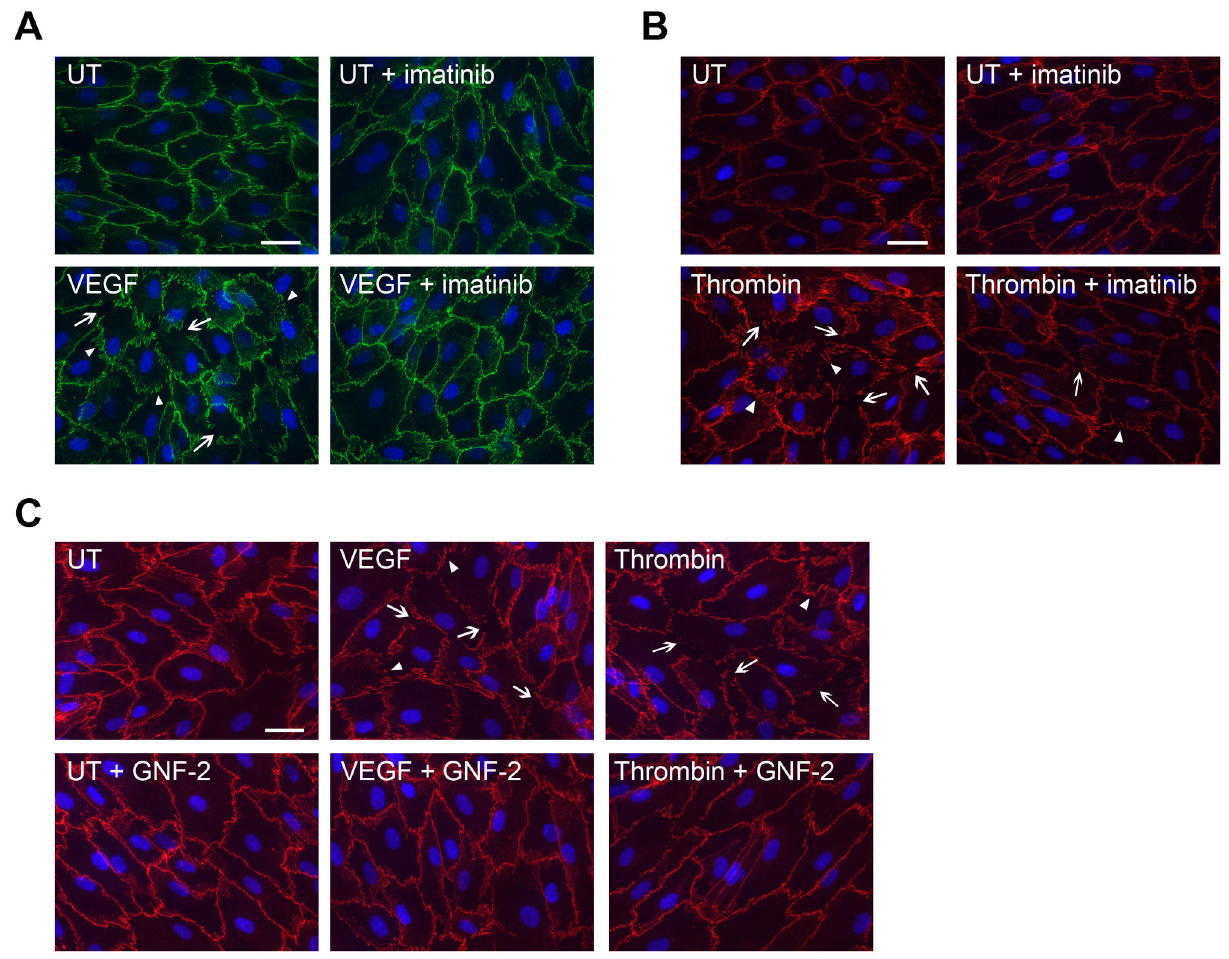
Figure 4. Abl kinase activity is required for VEGF- and thrombin-induced disruption of endothelial adherens junctions. ( A ) Staining of HMVEC monolayers for the adherens junction marker VE-cadherin (green) following treatment with VEGF (100ng/mL, 30 minutes), with or without imatinib pre-treatment (10μM). ( B ) VE-cadherin staining (red) of HMVEC monolayers treated with thrombin (1U/mL, 5 minutes), +/- imatinib. ( C ) VE-cadherin staining (red) of VEGF or thrombin-treated HMVECs, with or without GNF-2 pre-treatment (15μM). VEGF and thrombin treatment induced formation of inter-endothelial cell gaps (arrows) and destabilization of endothelial cell-cell junctions (“zig-zag” VE-cadherin staining pattern, arrowheads), which were reduced by pre- treatment with Abl kinase